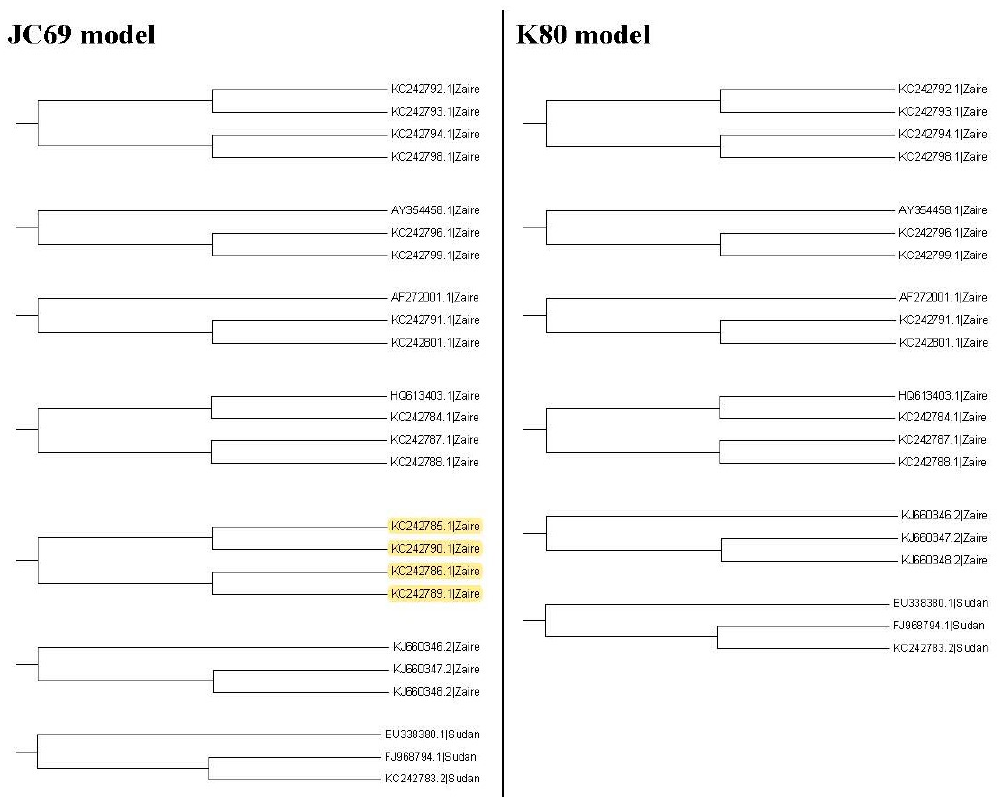
Figure 7. The second clades for the maximum likelihood trees based on the JC69 model and the K80 model. Yellow color: difference.